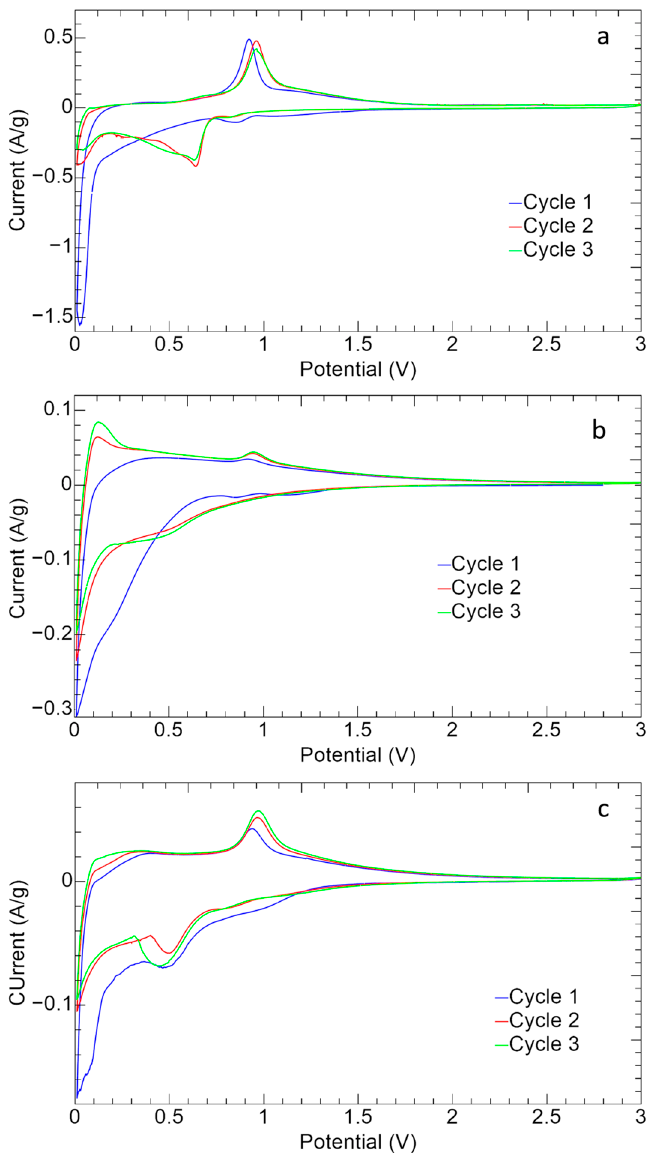
Figure 10. Cyclic voltammetry of ( a ) ZnS–GO, ( b )10%ZnS–GO/CNF and ( c ) 30%ZnS–GO/CNF samples. The charge/discharge cycles at di ff erent C-rates of ZnS–GO, 10%ZnS–GO/CNF and 30%ZnS–GO–CNF samples are reported in Figure 11.